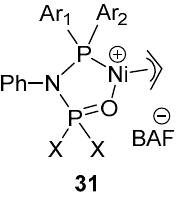
Figure 27. 2-Methylallyl- and allyl-based nickel catalysts bearing PNPO ligands 30a – f . Figure 28. Phosphine phosphonic amide nickel catalysts 31a – e .